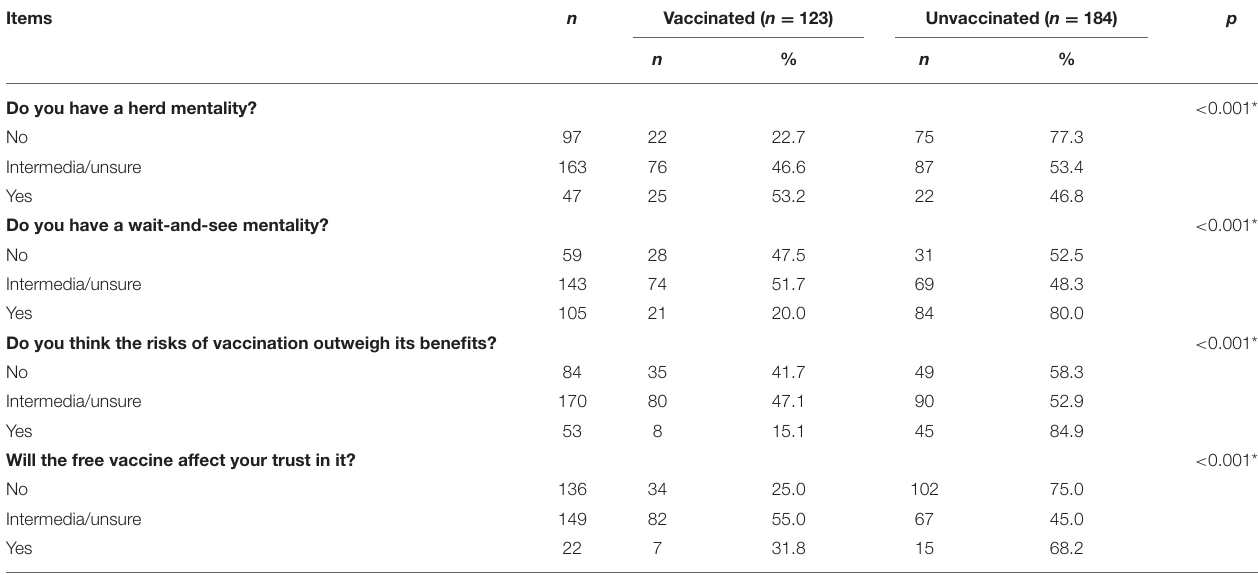
TABLE 3 | Effect of psychological factors on vaccination behavior of COVID-19 vaccine hesitators.